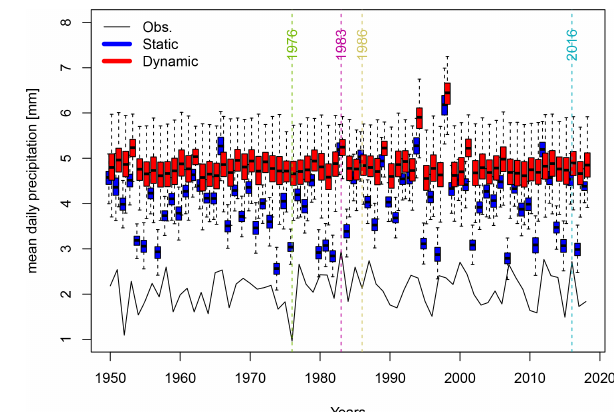
Figure 6. Daily precipitation averages for April–July from 1950 to 2018. The black line shows E-OBS observations. The boxplots rep- resent the ensemble variability of the simulations of the static (blue) and the dynamic (red) SWG for each year. The boxes of boxplots indicate the median ( q 50), lower ( q 25), and upper ( q 75) quartiles. The upper whiskers indicate min [ max( T ) , 1 . 5 × ( q 75 − q 25)]. The lower whisker has a symmetrical formulation. The points are the simulated values that are above or below the defined whiskers. The coloured vertical lines indicate the driest April–July period (1976), the wettest period (1983), a median period (1986), and 2016.